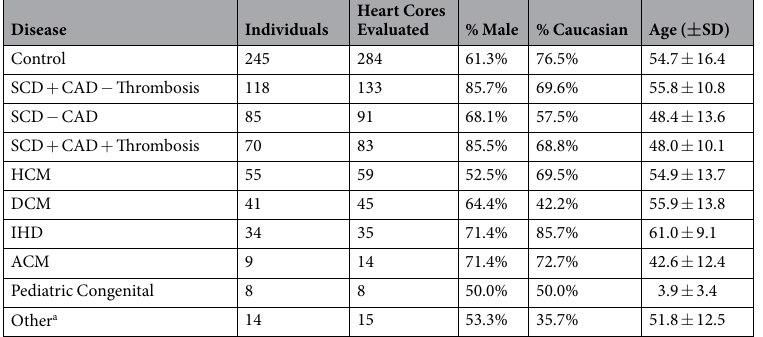
Table 1. Patient demographics of heart samples across 5 TMAs. Key. SCD = Sudden Cardiac Death; CAD = Coronary Artery Disease; CM = Cardiomyopathy; a includes cardiomegaly, chronic active myocarditis, right heart failure, noncompaction cardiomyopathy, retransplant, sarcoidosis, and other unclassified